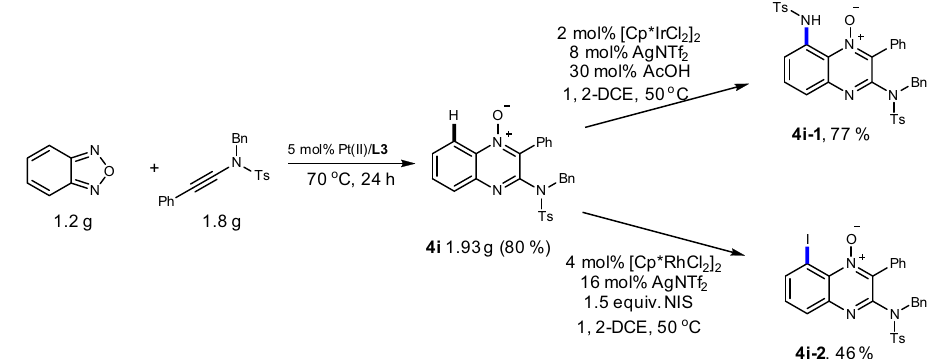
Fig. 5 Synthetic transformations by C – H functionalization. Gram-scale synthesis of quinoxaline N -oxide 4i . Iridium-catalyzed directed C – H bond amination. Rhodium-catalyzed directed C – H bond iodination.